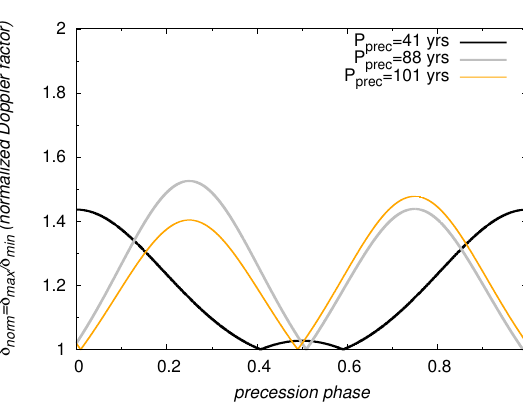
Figure 11. The normalized Doppler-beaming factor δ norm = δ max / δ min as a function of the precession phase for three different precession solutions indicated in the key according to the precession period (see Tables 1 and 2 for